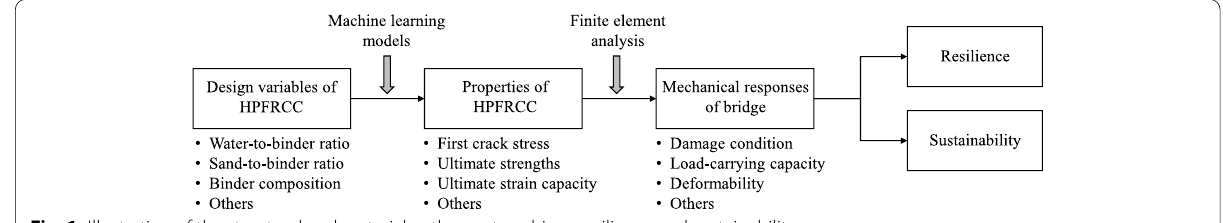
Fig. 1 Illustration of the structural and material pathways to achieve resilience and